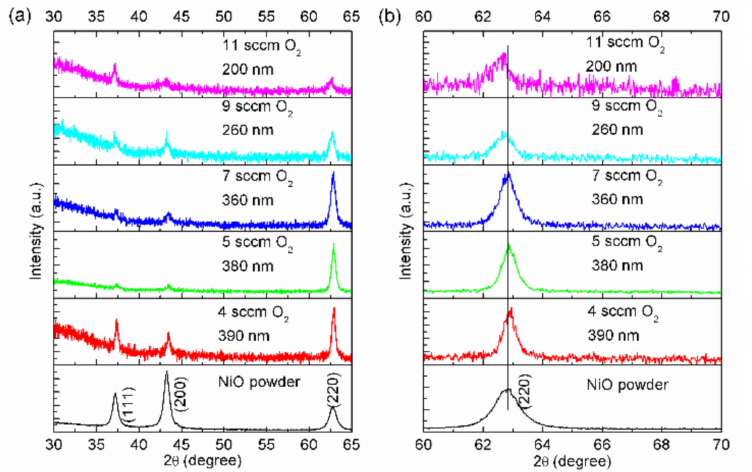
Figure 1. ( a ) θ –2 θ scan diffractograms of NiO thin films (200–390 nm) deposited on glass substrates with different oxygen flow rates. The deposition time was fixed at 6 min. The diffractogram of NiO powder is plotted at the bottom as a reference. ( b ) Magnified (220) diffraction peaks of NiO.